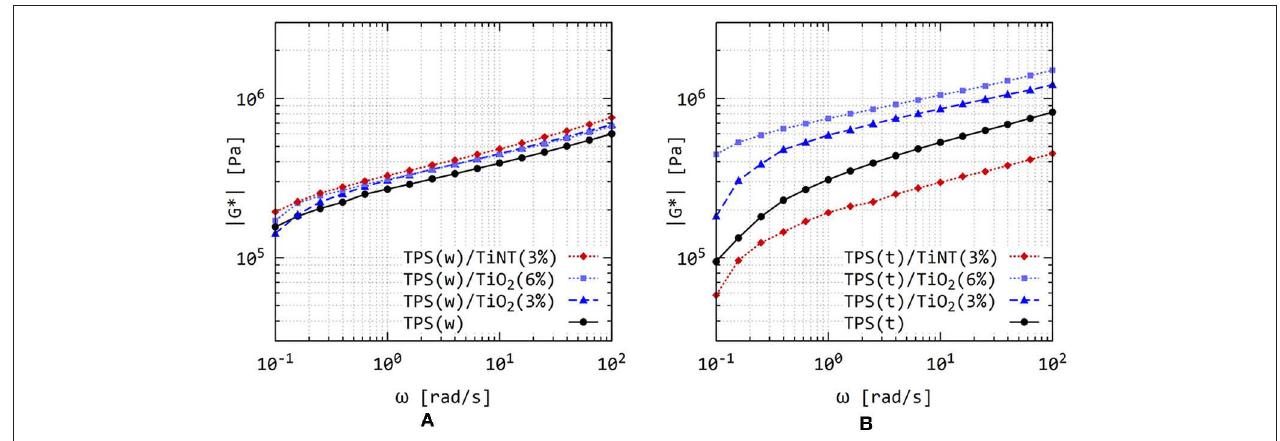
FIGURE 8 | The absolute values of complex modulus (|G*|) of wheat (A) and tapioca (B) TPS/TiX composites at 120 ◦ C and strain 0.02%.